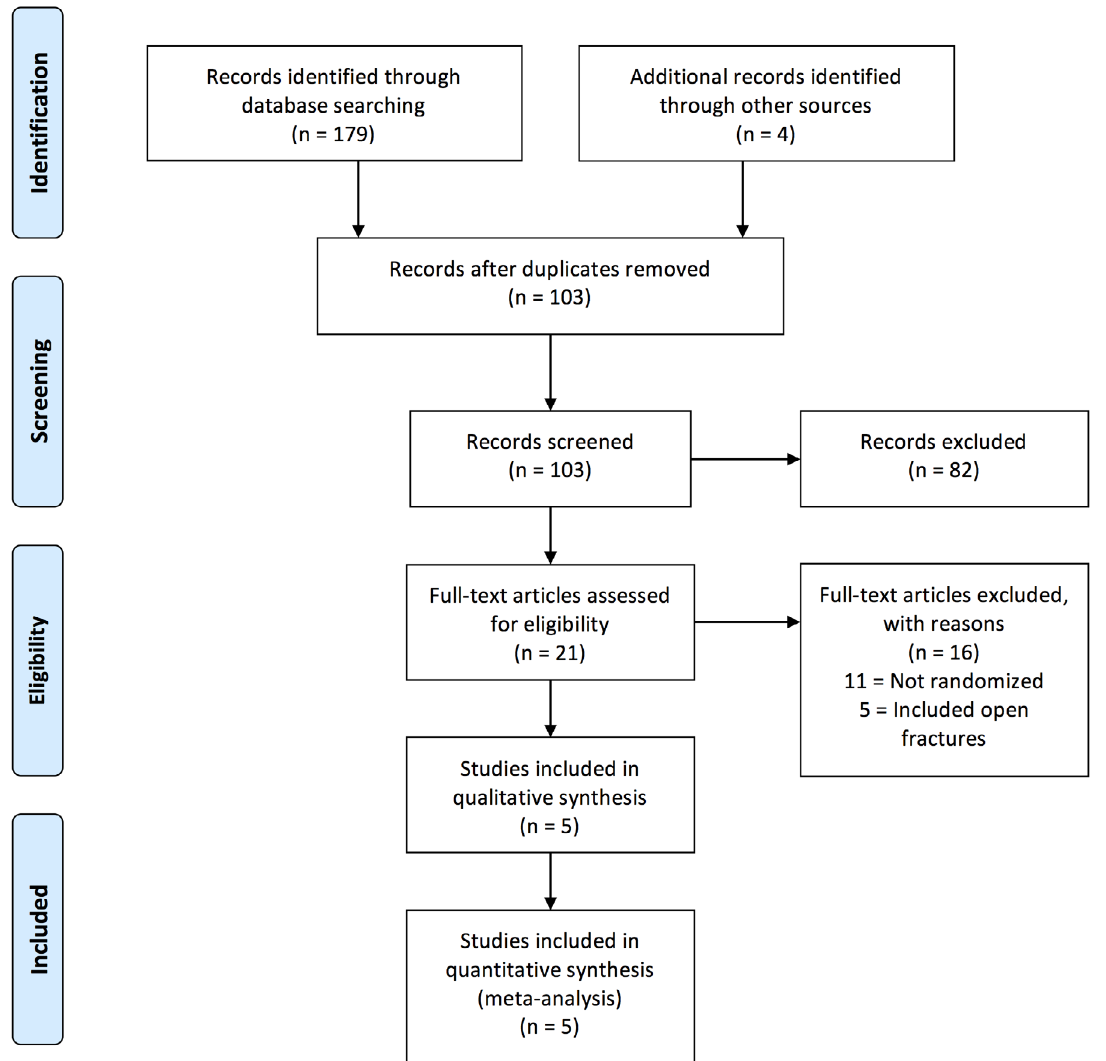
Fig. 1. PRISMA fl ow